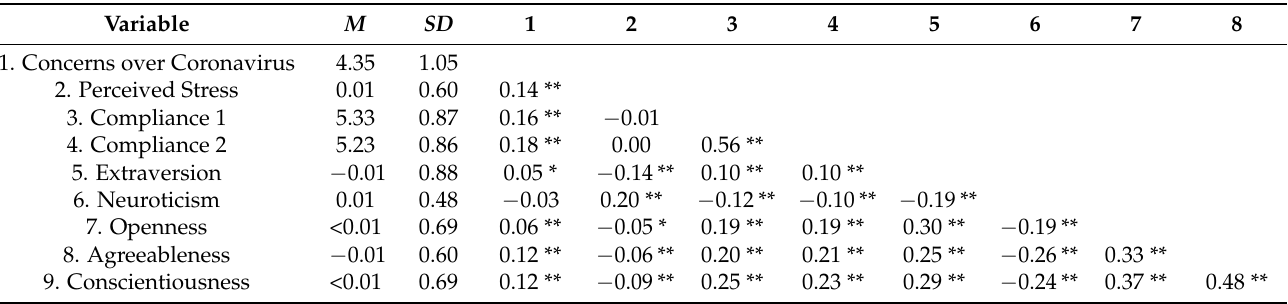
Table 2. Means, Standard Deviations, and Correlations of all the Variables